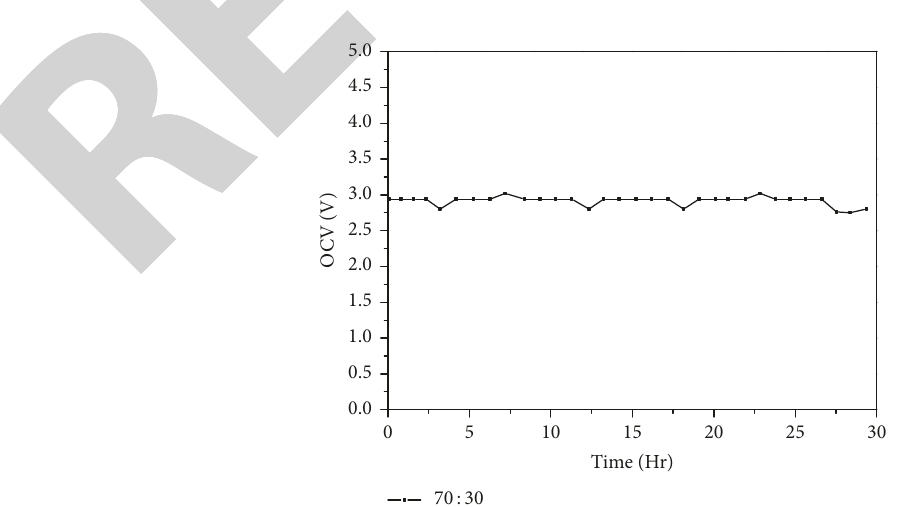
Figure11:(a)Potentialversuscapacitycurvesofsolidpolymerelectrolytefilmfor(70 : 30)wt%ratio.(b)Cellvoltageversuschargetimeversus cell capacity of solid polymer electrolyte film for (70 :30) wt% ratio. (c) Capacity retention versus cycle number of solid polymer electrolyte film for (70 :30) wt% ratio.